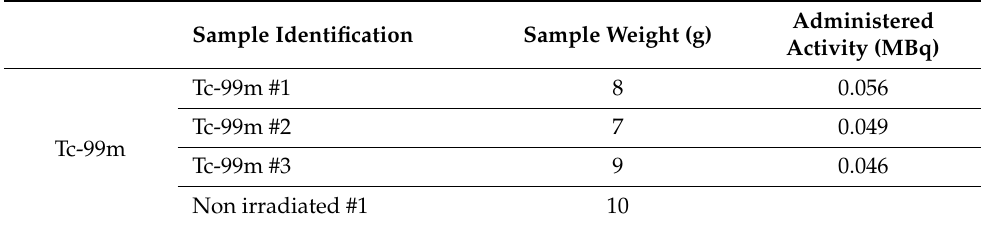
Table 3. Weight and activity used from each aliquot (#-sample number). Sample